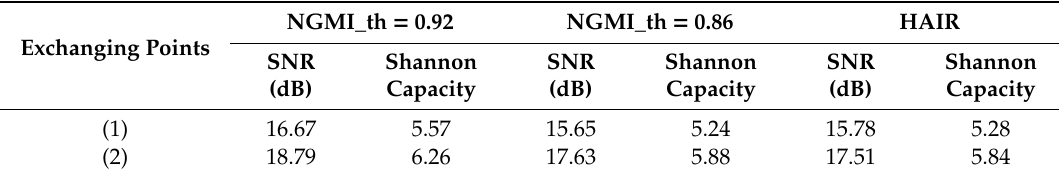
Table 2. QAM order exchanging point and corresponding SNR.